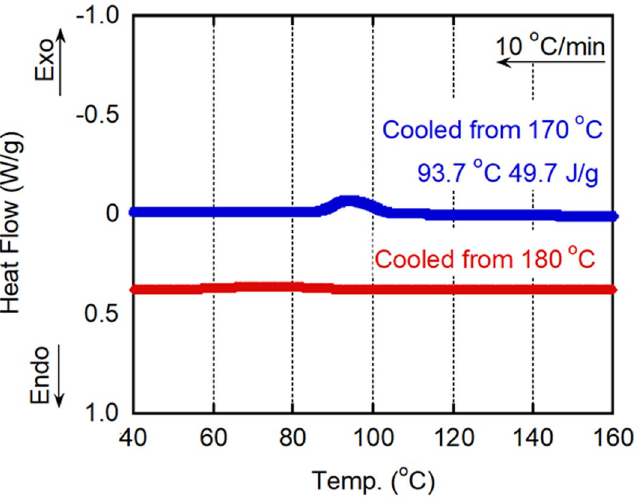
Figure 3. Differential scanning calorimetry (DSC) cooling curves obtained at 10 °C min −1 . The samples were cooled from 170 and 180